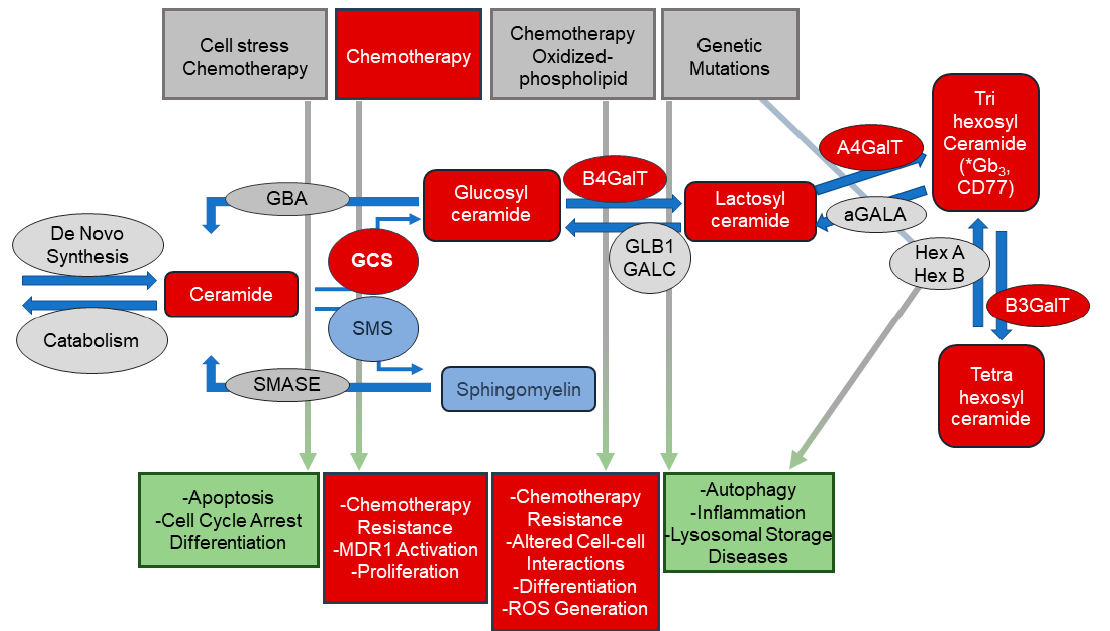
Figure 1. Overview of sphingolipid metabolism and biology. This scheme depicts stimuli and biologies associated with bioactive sphingolipids in the regulation of critical cellular biologic processes. Ceramides, and other sphingolipids, are important signaling molecules in numerous processes including apoptosis and cell cycle arrest. Upregulation of the pathways converting ceramide to complex glycosphingolipids (via the addition of sugar moieties) or to sphingomyelin (via the addition of phosphocholine) decreasing cellular ceramide levels may allow cancer cells to escape apoptosis. Increased levels of glycosphingolipids have been implicated in multi-drug resistance (MDR) in cancer cells. The metabolic pathways that generated these bioactive lipids are tightly regulated. Enzyme expression and / or activity are altered by several exogenous stimuli and the resulting alterations in lipid levels result in numerous cellular and biologic responses. Sphingolipids (and their associated metabolic enzymes) identified in plasma from PCa patients using untargeted metabolomic analyses are indicated in red. * putative IDs based on glycosylation patterns. α GALA: alpha-galactosidase; A4GalT: lactosylceramide 4-alpha-galactosyltransferase; B3GALT: beta-1,3-galctosyltransferase; B4GalT: beta-1,4-galctosyltransferase 1; GALC: galactosylcerbrosidase; GBA: glucosylceramidase; GCS: glucosylceramide synthase; HexA / HexB: hexosaminidase alpha / beta; SMASE: sphingomyelinase; SMS: sphingomyelin synthase.